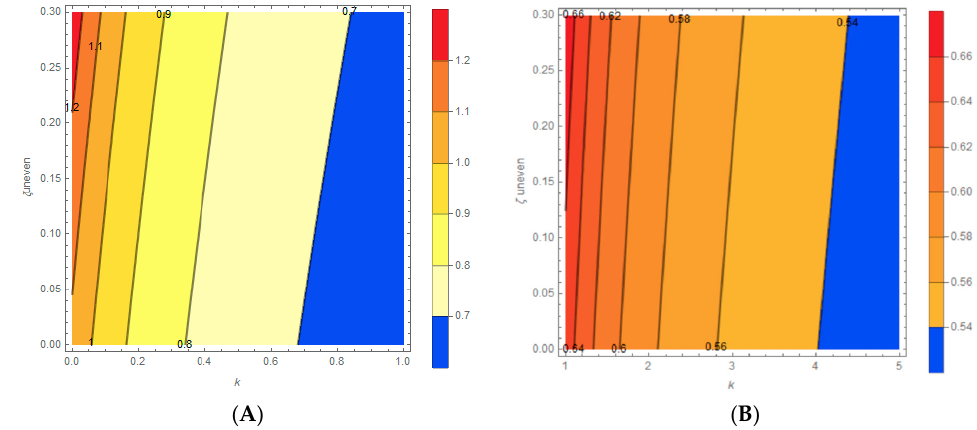
Figure 8. Simply-supported porous FG nano-beams: frequency ratio in terms of porosity volume fraction ( 𝜁 ) and gradient index ( 𝑘 ) with 𝒜 (cid:3050) = 0.2, 𝒜 (cid:2868) = 0.0 and 𝐾(cid:3561) (cid:3050) = 0: (A) uneven distribution of porosity and 𝑘 <1, and (B) uneven distribution of porosity and 𝑘 >1.